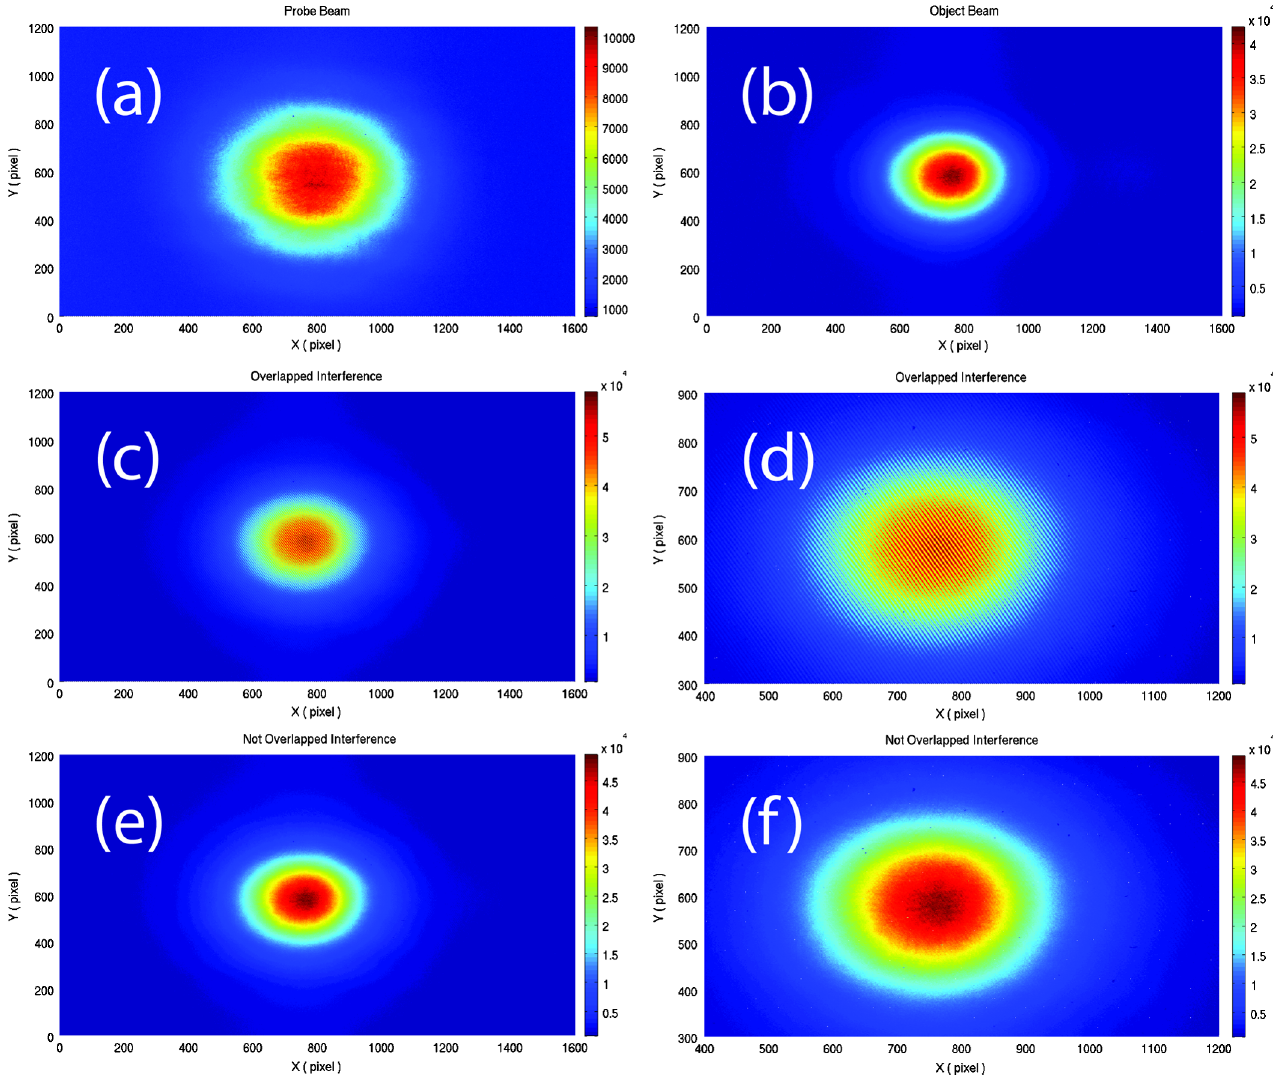
FIG. 4. The raw data for the stacked soliton case: (a) the probe beam ( img probe and object beam when they overlap in the time domain (the interference, img 1 of the probe and object beam when they do not overlap in the time domain (the interference, img 2